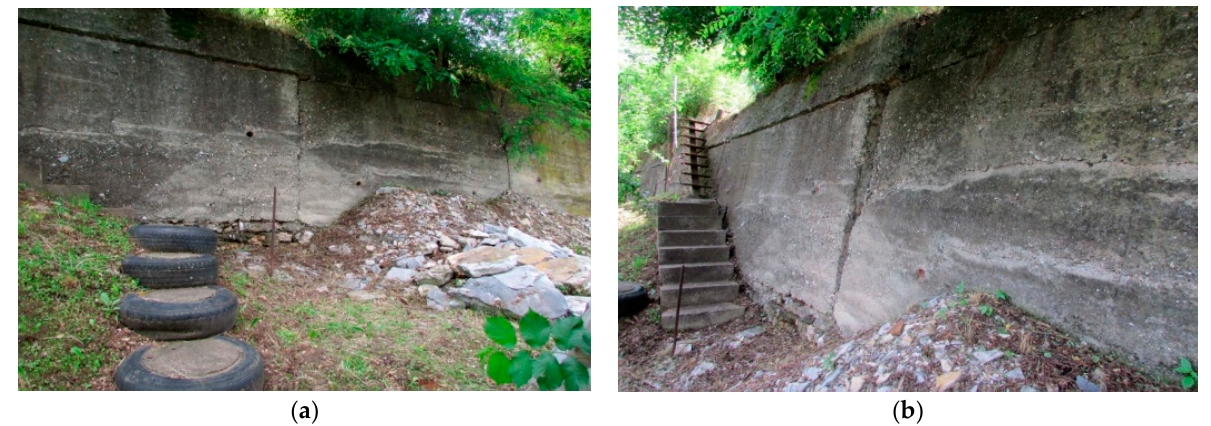
Figure 7. Details of the supporting wall in the basis of the road embankment at the site “Pej č ina krivina” ( a ) right view; ( b ) left view [28].